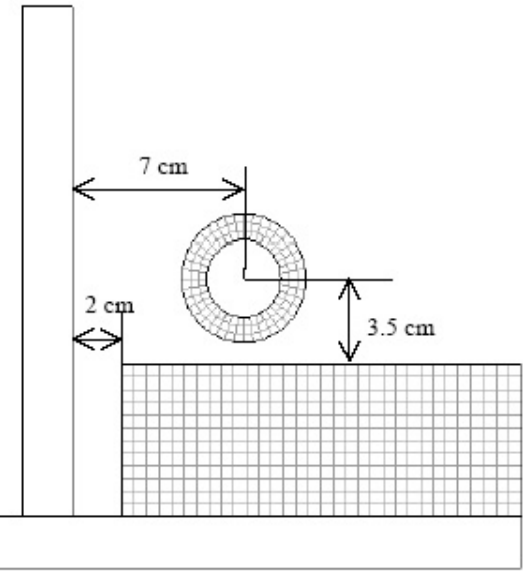
Fig. 6. Initial configurations and